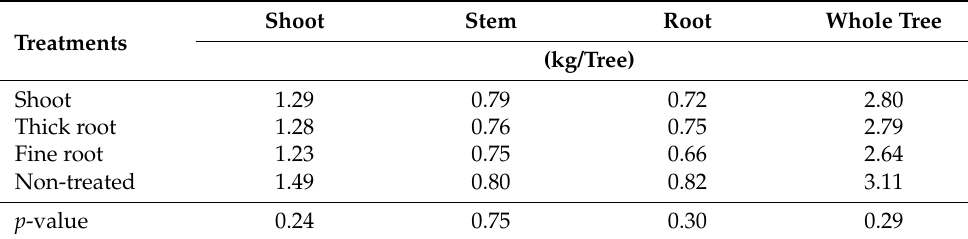
Table 4. The raw weight of trees in soil mixed with shoot and roots of Japanese pear trees. Shoot Stem Treatments